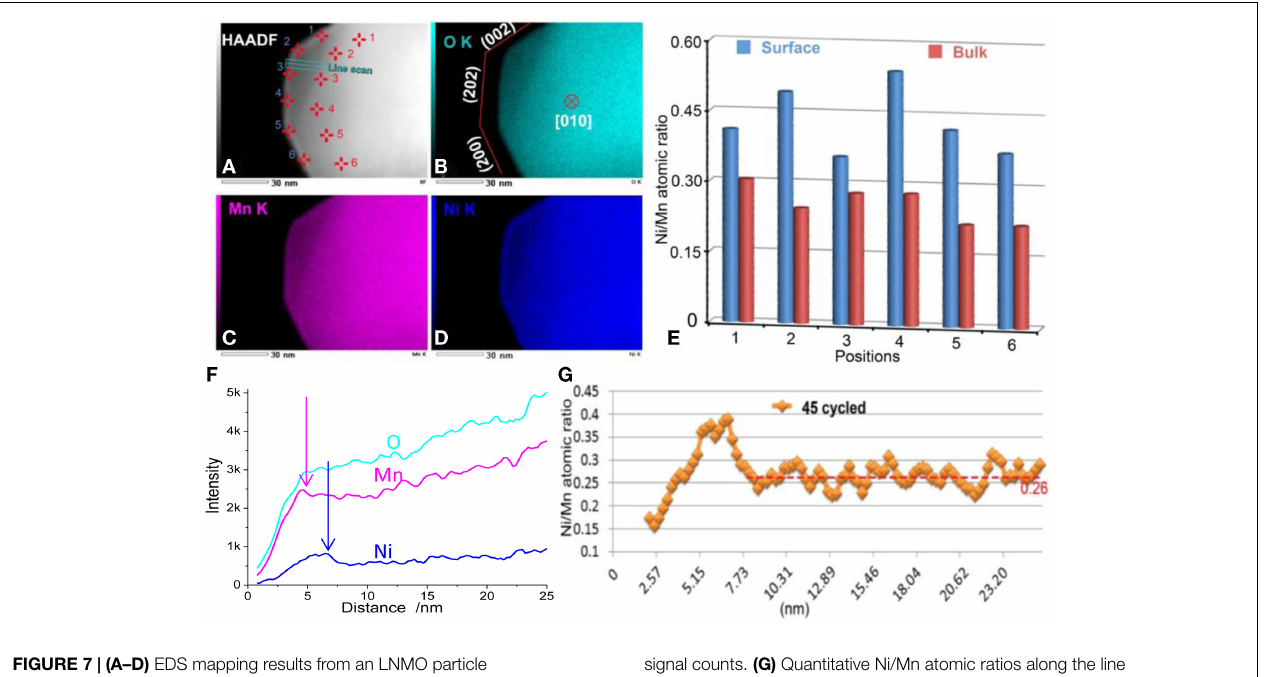
FIGURE 7 | (A–D) EDS mapping results from an LNMO particle cycled 45 times. The particle was tilted to the [010] zone axis and three surface facets were determined in (B) . (E) Quantitative Ni/Mn ratios from surface and bulk positions as marked in (A) . (F) Line scan